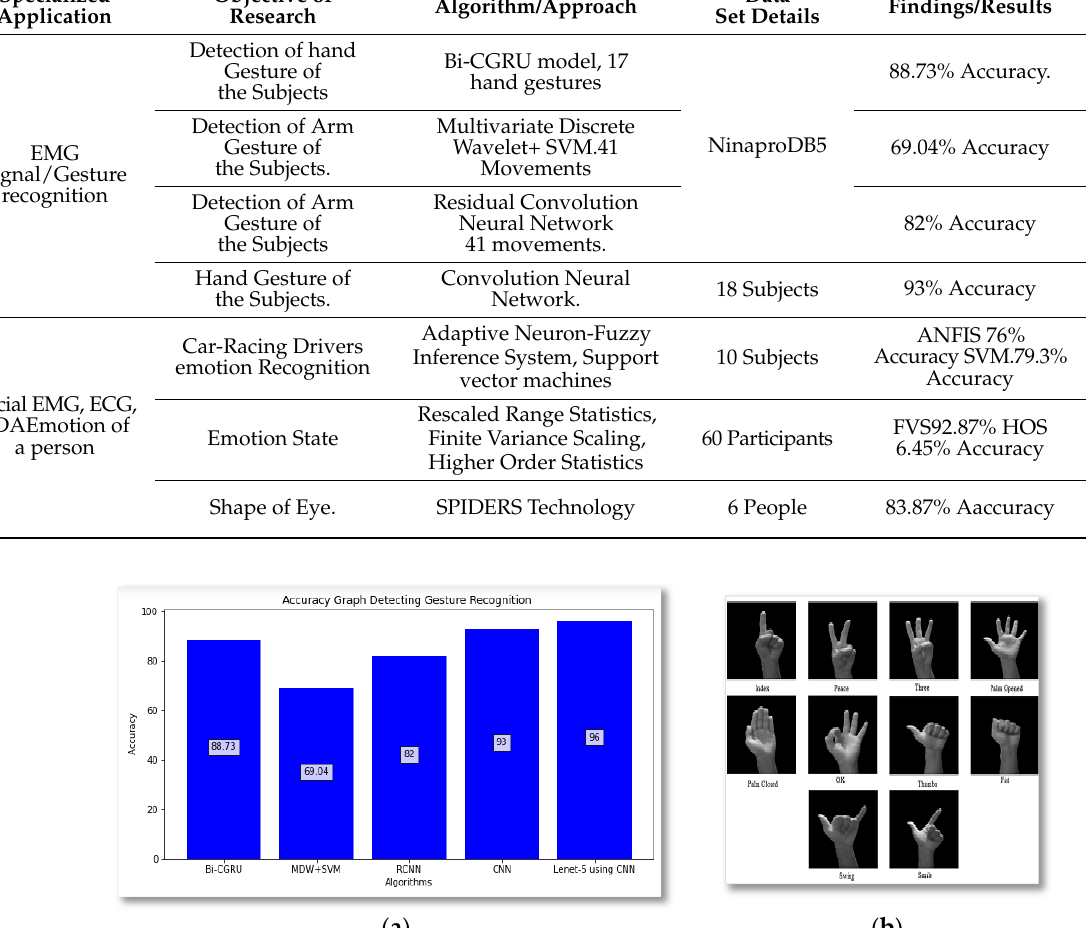
Figure 7. ( a ) Accuracy of gesture recognition, ( b ) hand gestures, reprinted with permission from [85]. The emotion of a person is recognized using different algorithms and its accuracy is measured in Table 7. The sample face expressions are shown in Figure 8b and graphical accuracy is shown in Figure 8a.